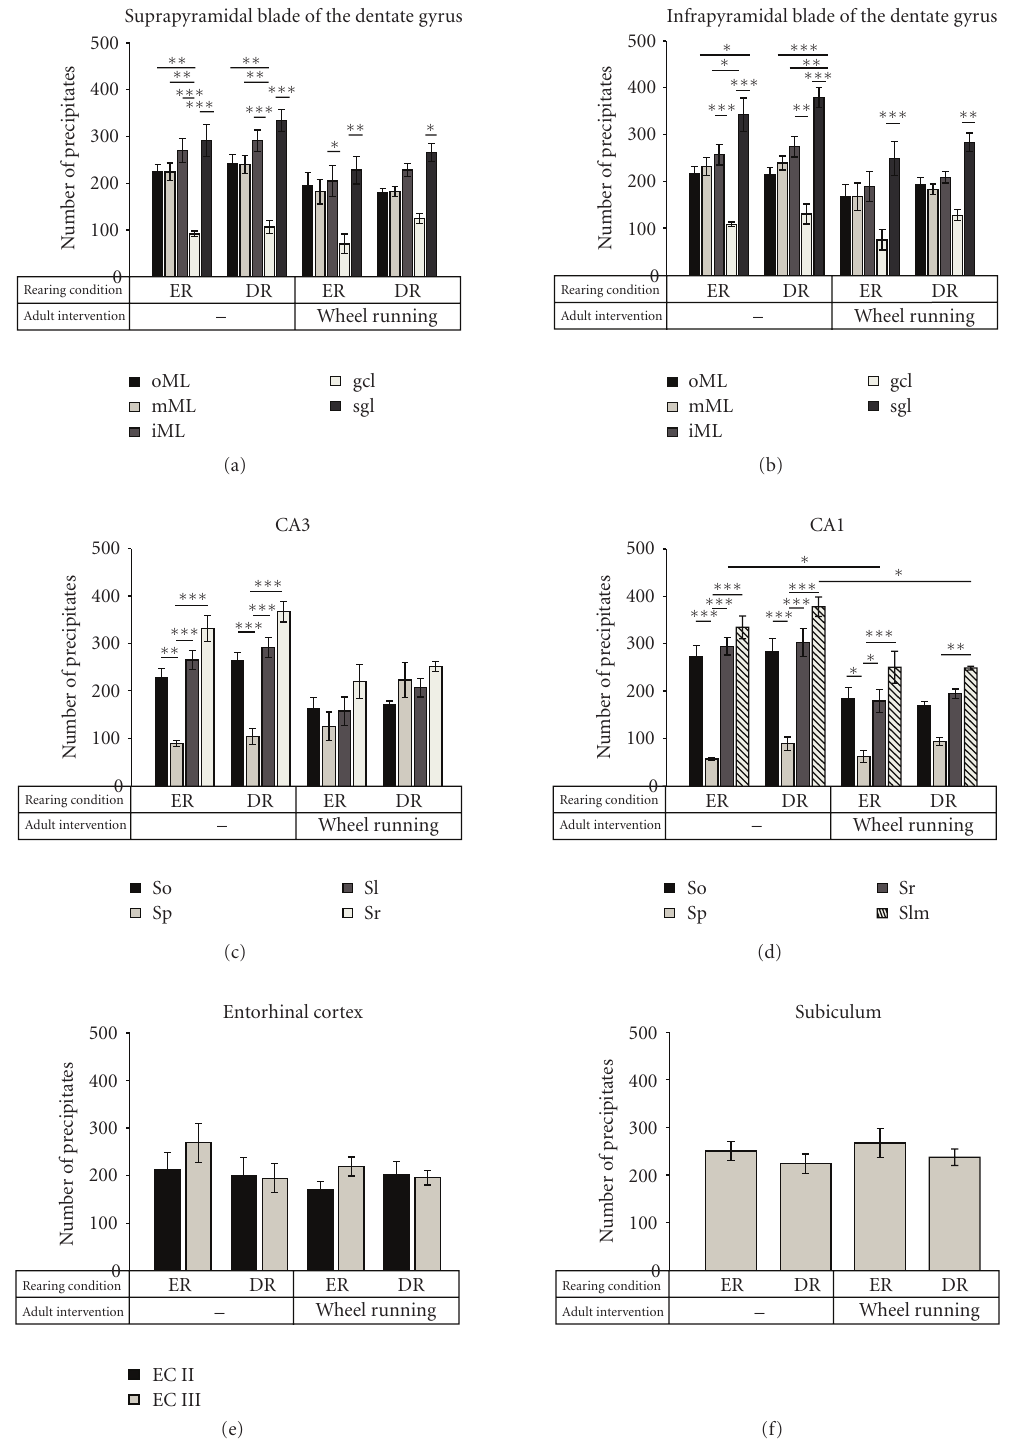
Figure 3: Number of precipitates for each layer in the (a) suprapyramidal and (b) infrapyramidal blade of the dentate gyrus, in the (c) CA3, (d) CA1, (e) entorhinal cortex, and (f) subiculum of the di ff erent treatment groups; ER: socially and physically enriched-reared animals; DR: socially and physically deprived-reared animals; wheel running: additional wheel running challenge in adulthood (pd 74–78); oML: outer molecular layer; mML: intermediate molecular layer; iML: inner molecular layer; gcl: granule cell layer; sgl: subgranular layer; spb: suprapyramidal blade; ipb: infrapyramidal blade; So: stratum oriens, Sp: stratum pyramidale; Sl: stratum lucidum; Sr: stratum radiatum; Slm: stratum lacunosum-moleculare; EC II: entorhinal cortex lamina II; EC III: entorhinal cortex lamina III; data given as means ± S.E.M., asterisks denote significant di ff erences: ∗ P < . 05, ∗∗ P < . 01, ∗∗∗ P < .